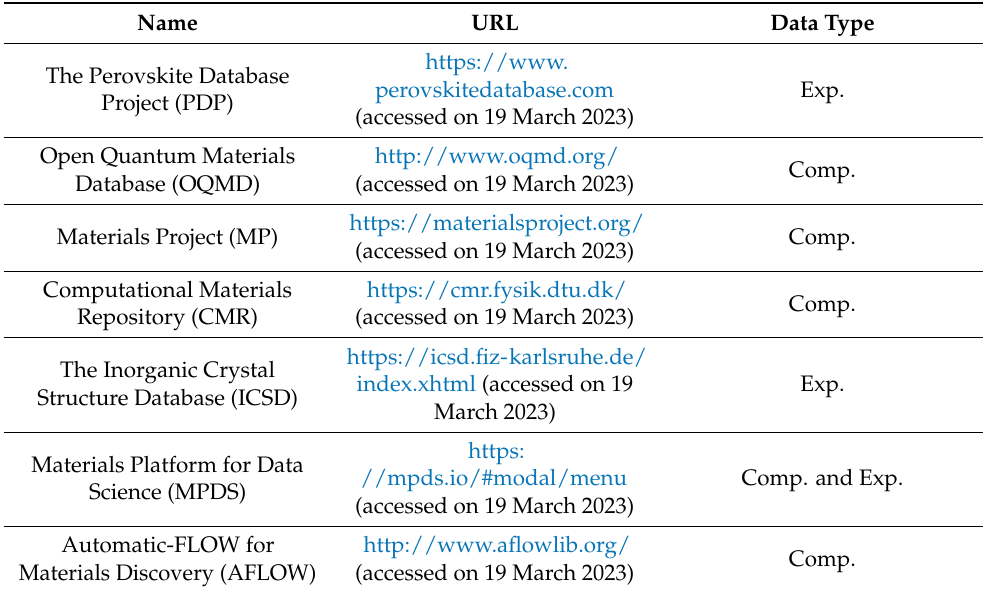
Table 1. Commonly used materials databases, including